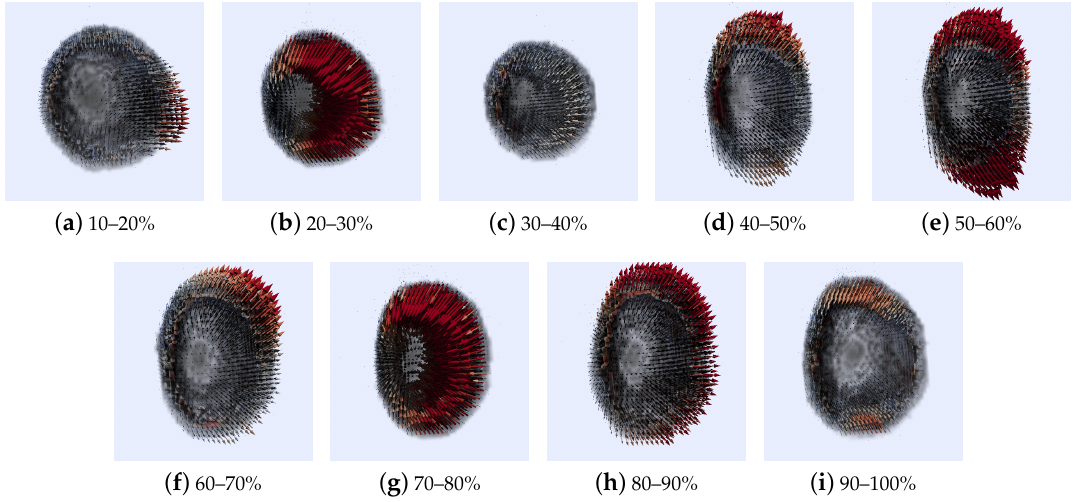
Figure 23. Results of 3D Optical Flow of a segmented cardiac CT volume (left ventricle–short